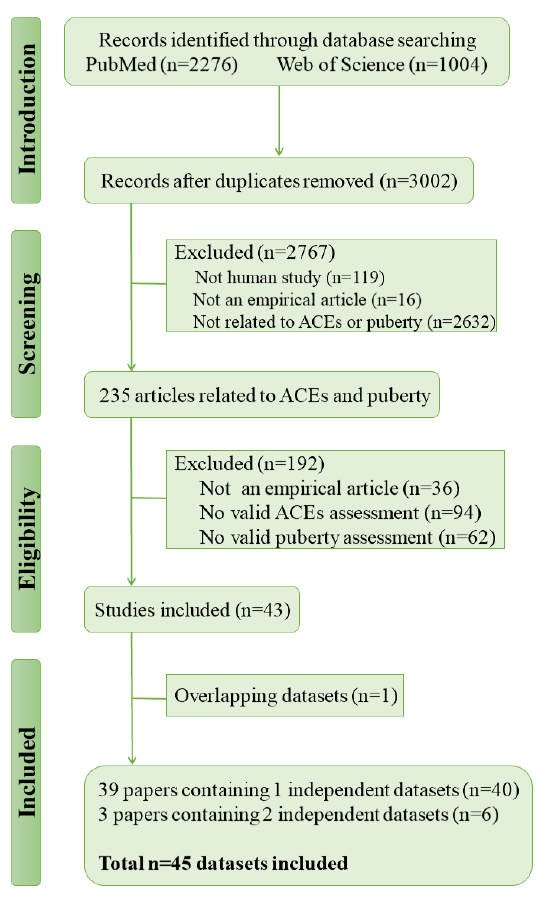
Figure 1. Flow chart of study selection. Table 1. Descriptive statistics and study characteristics for included studies.